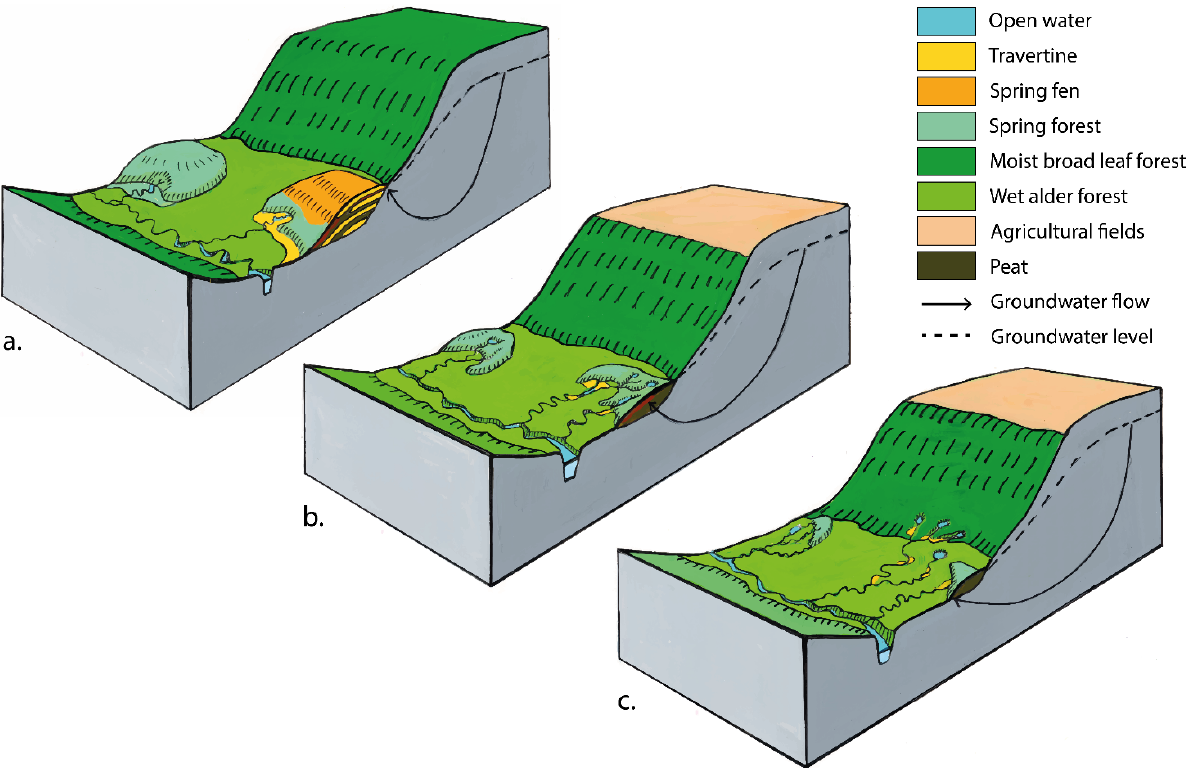
Figure 9: Speculative reconstruction of the degradation of alkaline fens in the NW-European lowlands. (a): undisturbed situation - before cutting of forest on the plateau - with alkaline spring fen and travertine deposition. (b): initial deteriorating phase induced by forest cutting, increased drainage and backward erosion, development of spring forests and petrifying springs with tufa deltas. (c): strongly deteriorated state - strong backward erosion formed groups of springs at a higher position on the slopes and resulted in near disappearance of peat. Only petrifying rivulets may still be